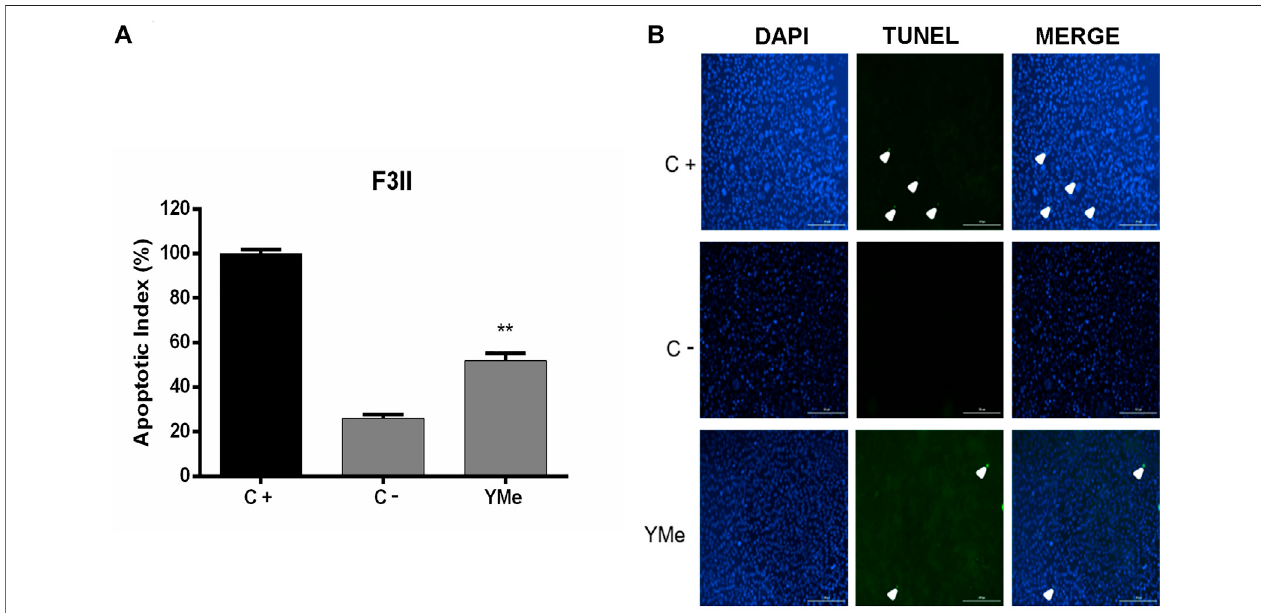
FIGURE 2 | Effect of YMe on apoptosis of F3II cells by TUNEL method. Terminal deoxynucleotidyl transferase nick end-labeling (TUNEL) was used to detect apoptotic cells. The cells treated with PBS were considered as negative control (C-) and cells treated with Camptotecin (10 µM) for 4 h were considered as positive control (C+). After 24 h of treatment, TUNEL assay was carried out. Assay was performed on cells growing in glass cover slips and then stained as described. (A) An increase in TUNEL staining in F3II cells treated with YMe was observed. The apoptotic index (AI) was calculated by the following formula: AI (cid:2) (Number of TUNEL- positive cells/Total number of cells) x 100. (B) Cells stained with TUNEL (green) and counterstained with DAPI (blue) respectively. Blue and green stain in the merged image represents the TUNEL-positive apoptotic cells. Scale bars (cid:2) 200 µm.